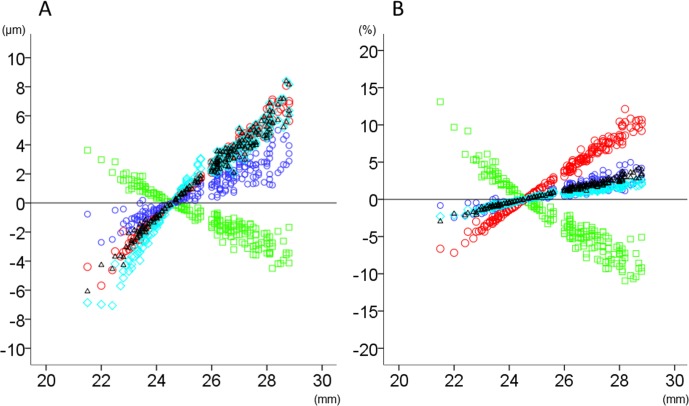
The relationship between axial length and thickness changes of retinal layers in the total analytical area after magnification correction.The thickness changes (μm; A) and relative thickness changes compared to the magnification-uncorrected thickness (%; B) after magnification correction were plotted against axial length. Green squares: retinal nerve fiber layer, Red circles: ganglion cell layer plus inner plexiform layer, Blue circles: ganglion cell complex, Light blue diamonds: total retina, Black triangles: outer retina.